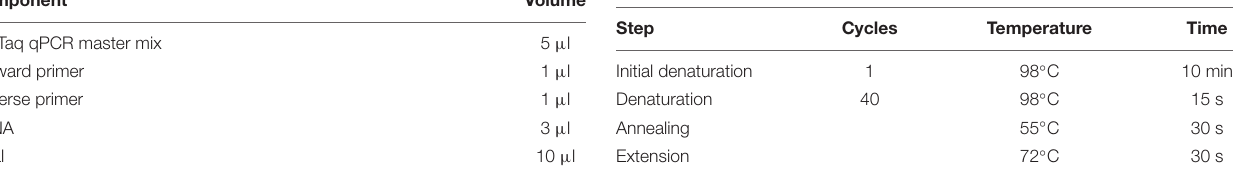
TABLE 11 | qRT-PCR cycling